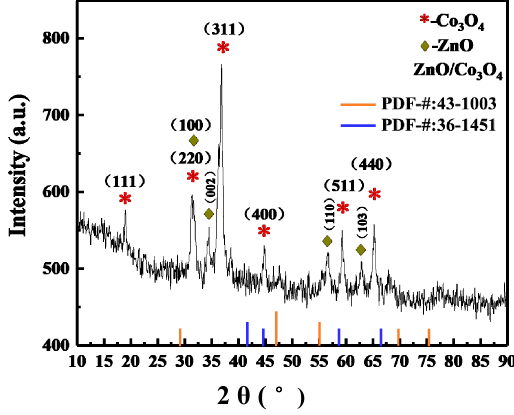
Figure 3. The XRD image of ZnO/Co 3 O 4 .